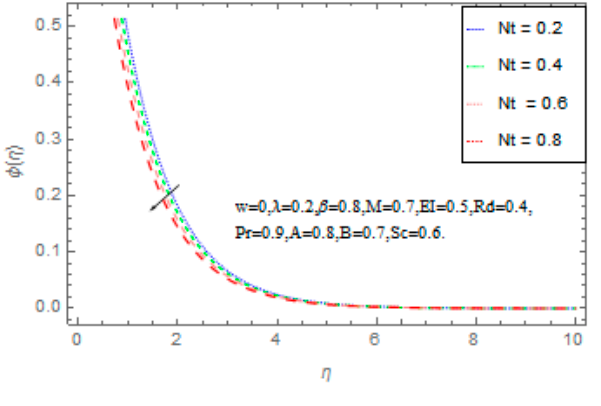
Figure 11. Influence of Nt on φ ( η ) Profile. Applied sciences 2018 , 17 , x FOR PEER REVIEW 15 of 19